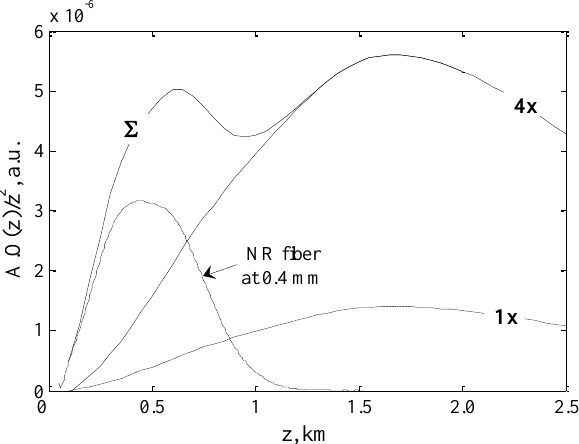
Fig. 6. Simulated signals in terms of AO ( z )/ z 2 disregarding the at- mospheric transmission: signal from one telescope (1×), signal from four telescopes (4×), total signal from four telescopes including the contribution of the near range fiber ( 6) .